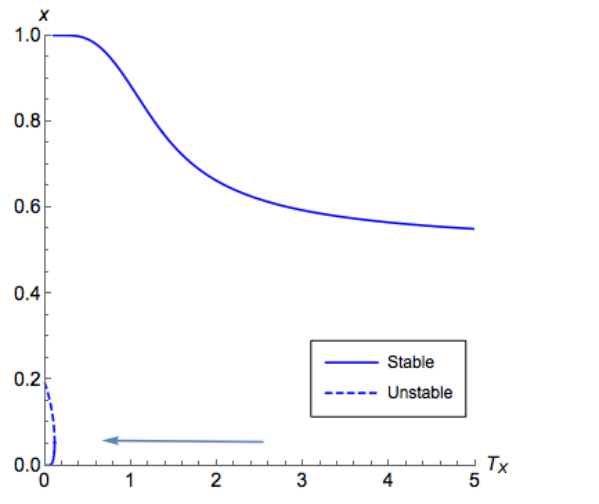
(cid:17) (cid:16) − δ δ 1 , b X . 2 Y a X + b X